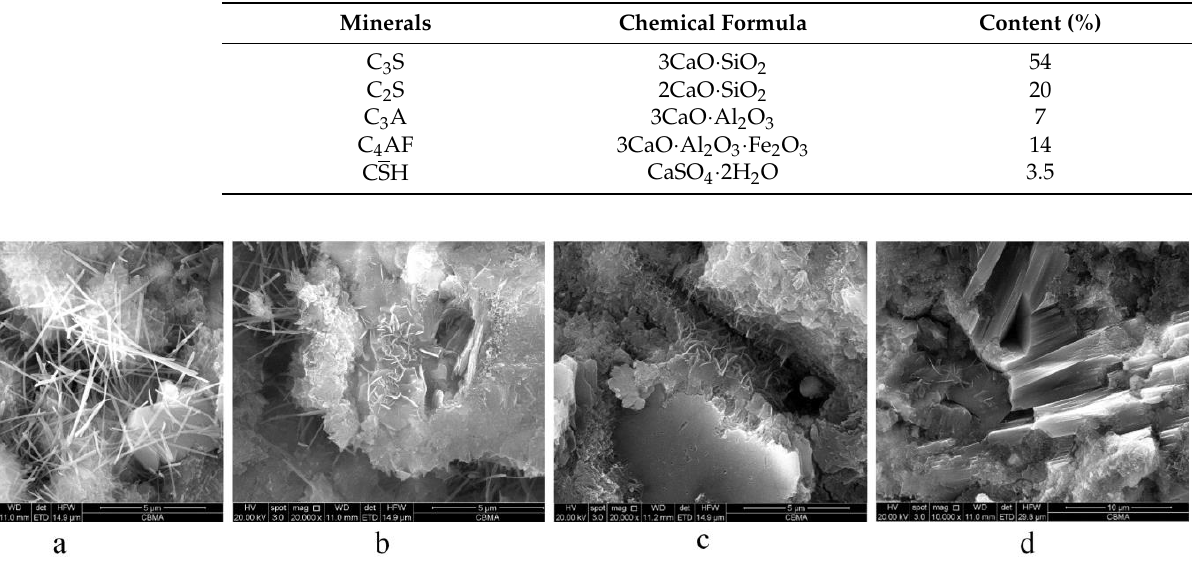
Figure 14. Hydration products of cement (SEM) [73]: ( a ) acicular Aft (3d); ( b ) flocculent CSH (3d); ( c ) stacked calcium hydroxide (7d); ( d ) rod AFt